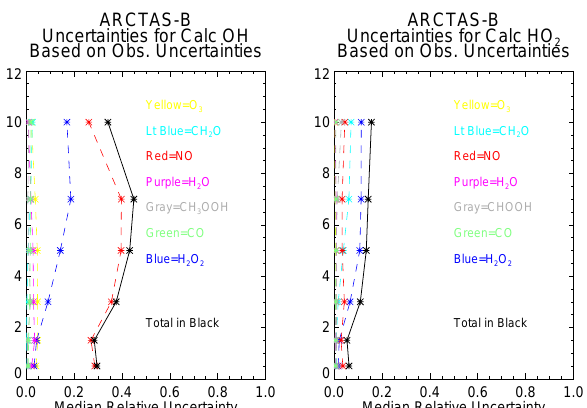
Fig. A2. As for Fig. A1, but for